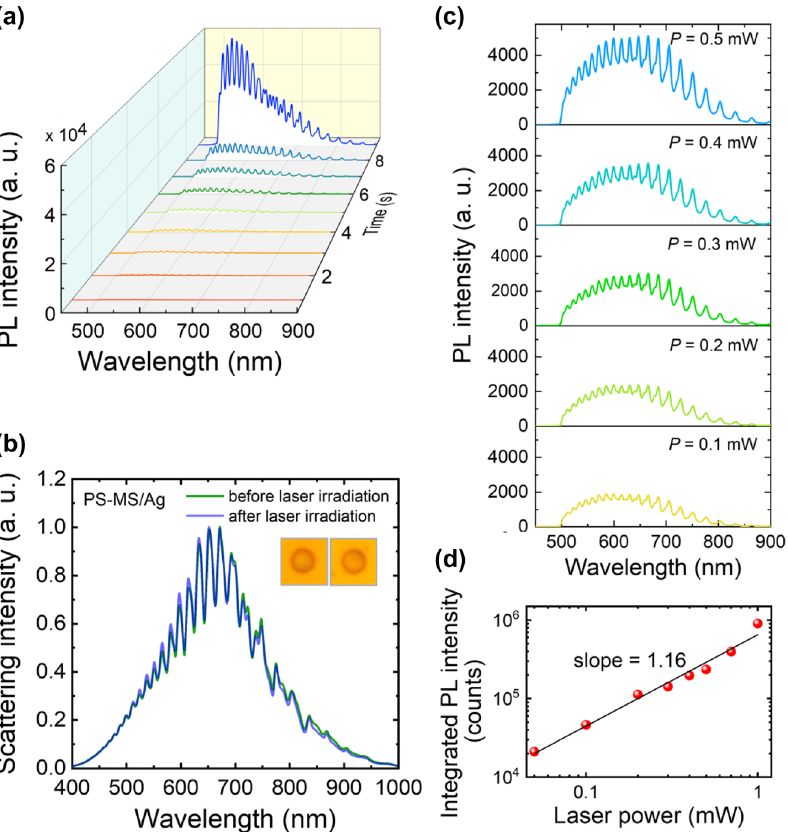
Figure 5: Emission from the WGMs supported by a PS-MS/Ag microcavity. (a) Evolution of the PL spectrum of a PS-MS/Ag microcavity with increasing irradiation time measured at a laser power of P = 2.5 mW. (b) Scattering spectra measured for the PS-MS/Ag microcavity before (green curve) and after (purple curve) laser irradiation. The bright-field images of the PS-MS/Ag microcavity before and after laser irradiation are shown in the insets. (c) PL spectra measured for the PS-MS/Ag microcavity at different laser powers below the threshold. (d) Dependence of the integrated PL intensity of the PS-MS/Ag microcavity on the laser